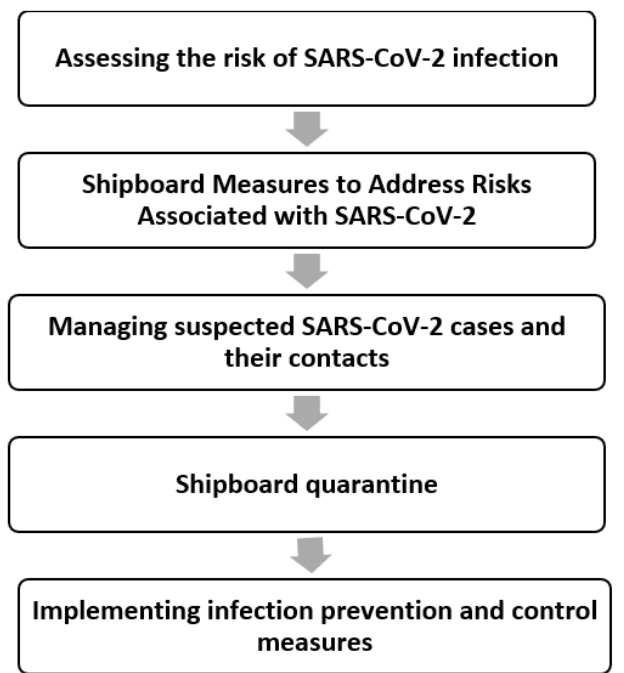
Figure 1. Guidance for implementing SARS-CoV-2 prevention and control strategies in the context of fishing communities.